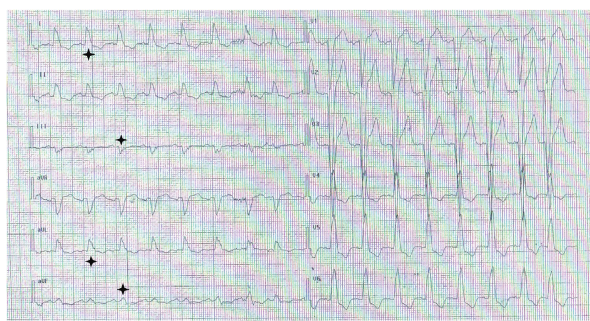
Figure 1: ECG showing true left bundle branch block: QRS du- ration 160 myocardial scar (male), QS in lead V 1 and rS in lead V 2 , plus mid-QRS notching in all involved leads ( V 1 and V 2 ; V 5 and V 6 ; DI and aVL). QRS complexes do not show fragmentation according to Das’ criteria. SSc is